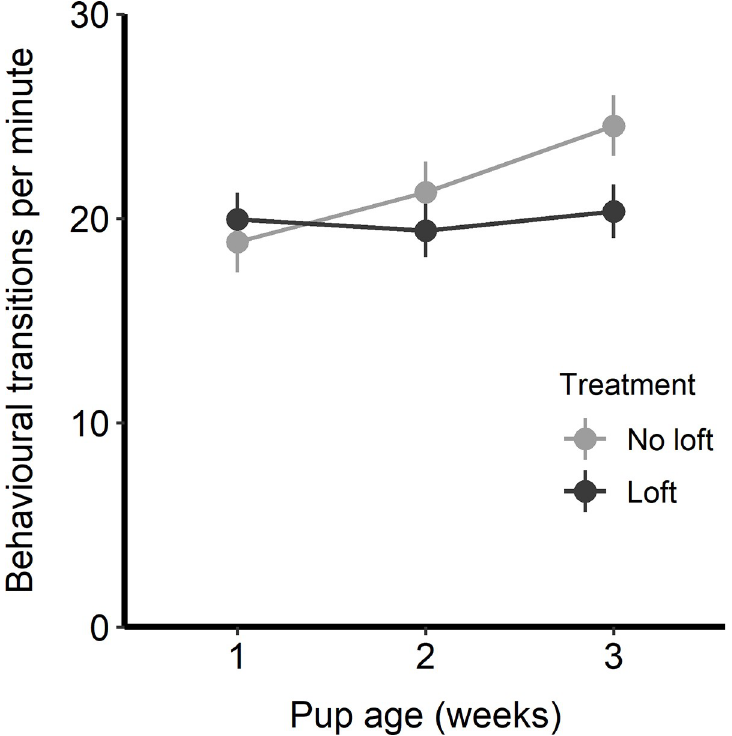
Fig 5. Behavioral transitions per minute during anticipatory behavior testing. Rats were assessed for this behavior twice per week and results were analyzed as weekly means. Results are shown separately by treatment. Plot depicts the LS means and standard errors from model output; n = 16 rats (9 in the loft treatment and 7 in the no loft treatment).